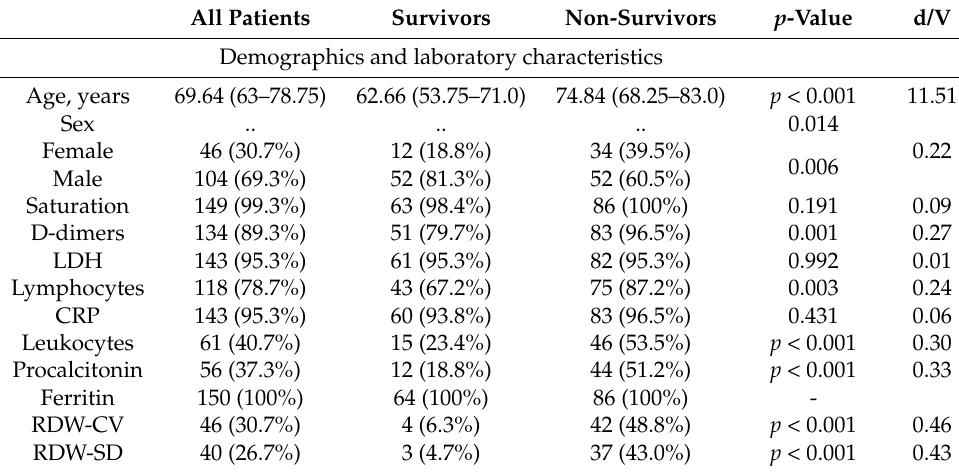
Table 1. Demographics and percentage of patients with laboratory results out of the reference range of survivors and non-surviving patients.